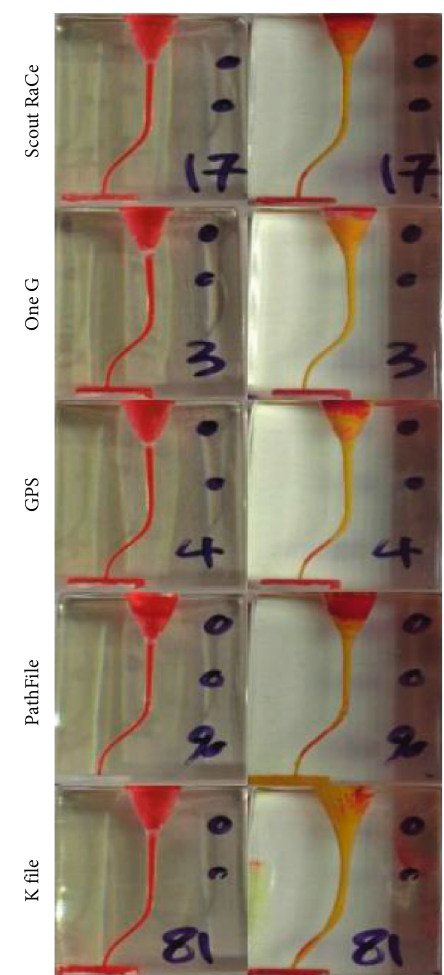
Figure 3: Representative images of before- and after-instrumentation pictures of each experimental Table 3: P values for each pairwise comparison in the intragroup analysis.